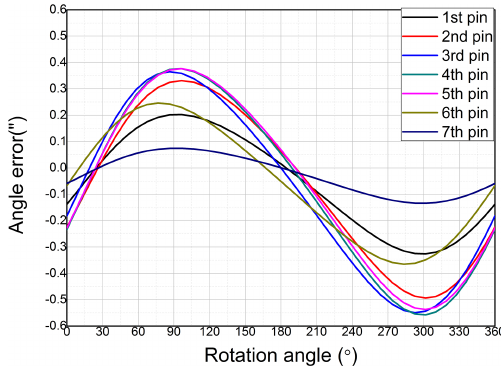
Figure 9. Angle error due to torsional deformation